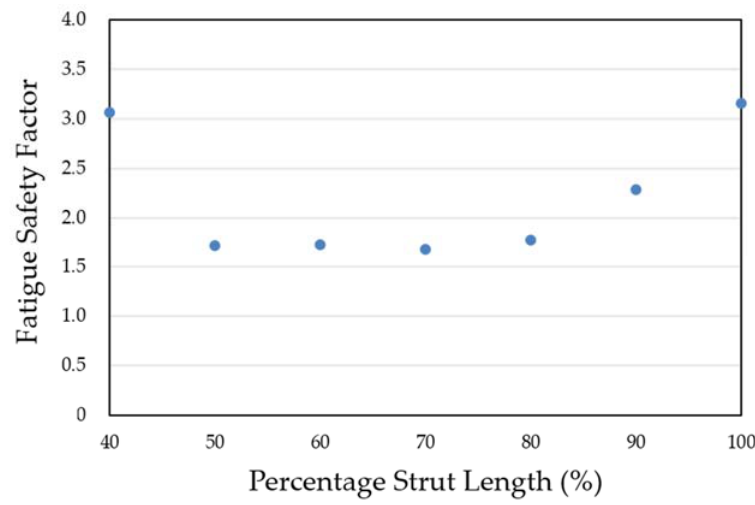
Figure 11. Simulation results of the fatigue safety factor as a function of the reservoir length.